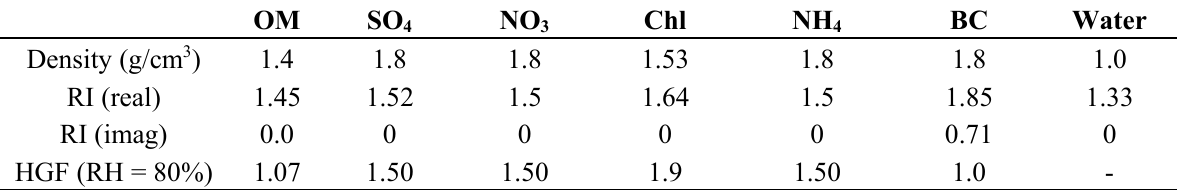
Table 1. Assumed size-independent density, real and imaginary parts of complex refractive index (RI) at 0.55 µm wavelength, and hygroscopic growth factor (HGF) values used in this study. Values are taken from